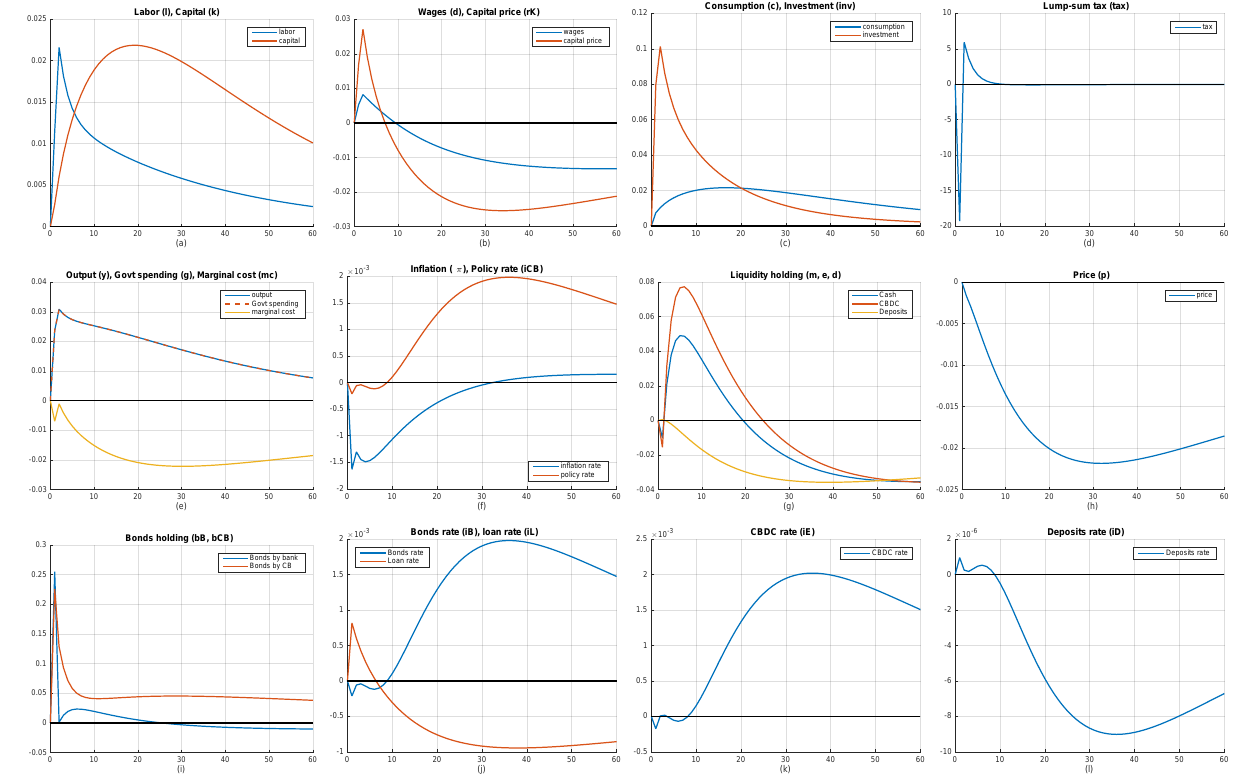
Figure 3. The effect of productivity shock on: ( a ) Labor l t and capital k t , ( b ) wages w t and price of capital r K , ( c ) consumption c t and investment inv t , ( d ) lump-sum tax tax t , ( e ) output y t , government t spending g t , and marginal cost mc t , ( f ) inflation π t and policy rate i CB , ( g ) liquidity holding m t , e t , d t , t ( h ) price p t , ( i ) bonds holding b B , b CB , ( j ) bond rate i B and loan rate i L , ( k ) CBDC rate i E , and ( l ) t t t t t deposits rate i D t